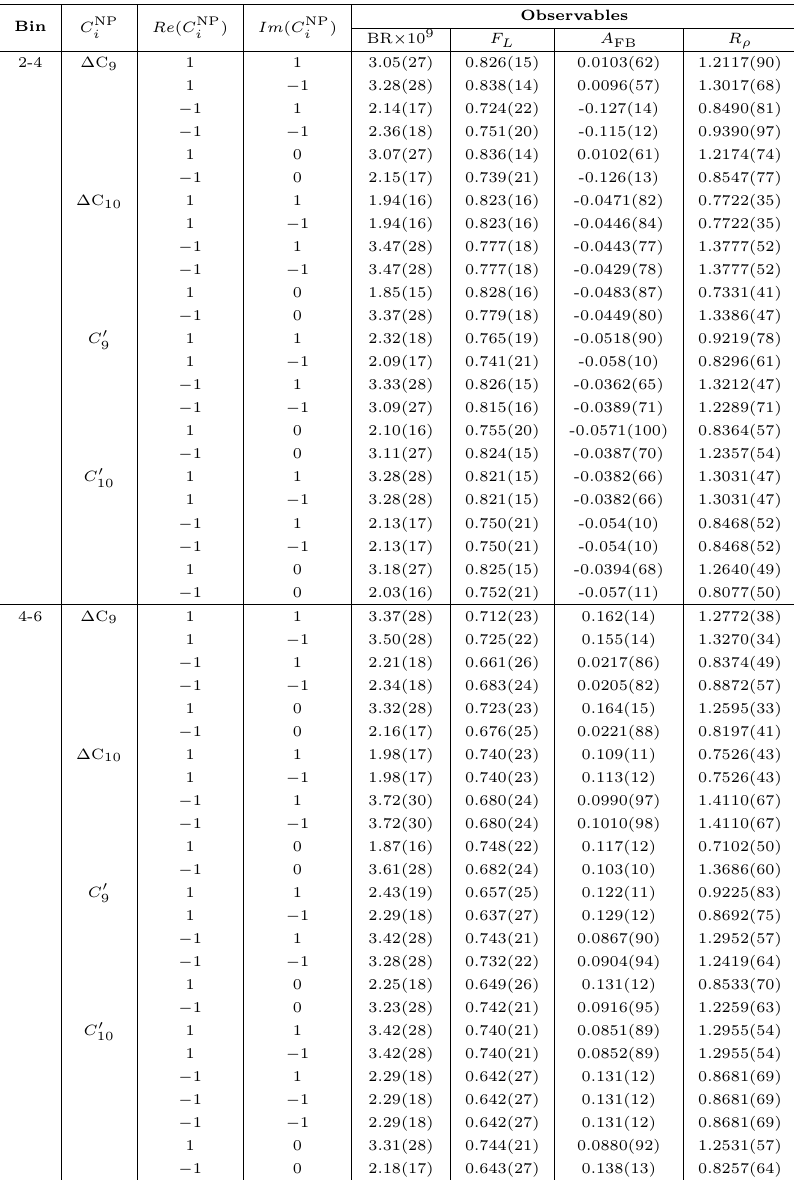
Table 27 . The dependence of the Branching Ratio and the observables F L , A FB and R ρ corre- sponding to B ± → ρ ± ll on the real and imaginary parts of the NP WC’s ∆ C q 2 bins 2 − 4 and 4 − 6 GeV 2 for a few benchmark values of the real and imaginary parts of the corresponding